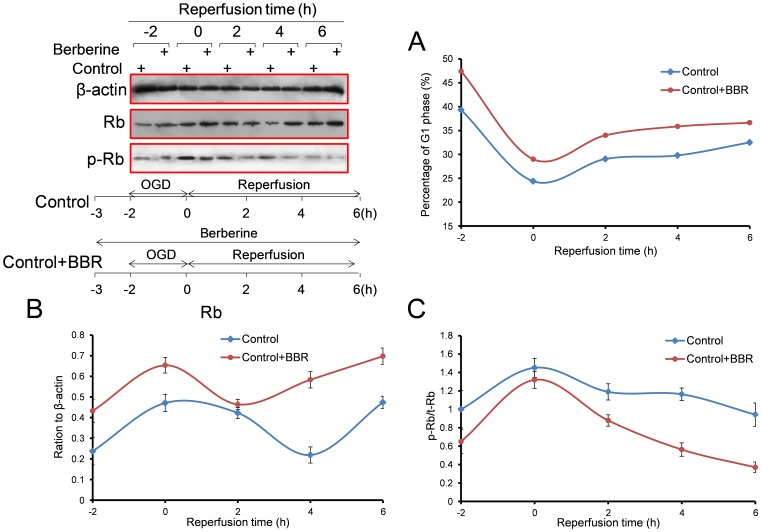
Effect of berberine (BBR) on the cell cycles and Rb expressions in PC12 cells during the 6 h of reperfusion after 2 h of OGD.(A) Expression of Rb proteins and time schedule of the experiment. (B) The percentage of cells in the G1 phase. (C) Total Rb protein. (D) Ratio of phosphor-Rb (S795) to total Rb (phosphor-Rb/Rb). Berberine (0.5 µg/ml) was added to the culture 1 h before OGD treatment and throughout reperfusion. Data are presented as mean ± S.D. of three independent experiments (n = 3).